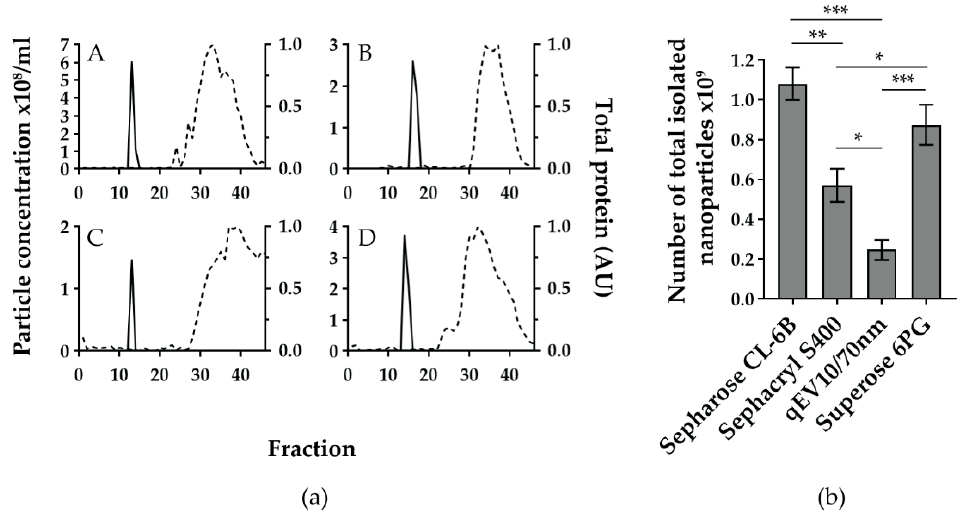
Figure 2. The four gravity-based size exclusion chromatographies (SEC) separate cerebrospinal fluid (CSF) to nanoparticle and free protein-enriched fractions but differ in yield of total nanoparticle number. ( a ) Sepharose CL-6B ( A ), Sephacryl S-400 ( B ), qEV10/70nm ( C ), and Superose 6PG ( D ) were used to separate the same pool of intracranial CSF samples from severe traumatic brain injury patients. For each SEC method, 46 fractions of approximately 1.5 mL were collected and analysed for nanoparticle concentration (solid line), measured by tunable resistive pulse sensing (TRPS) and total protein content (dashed line) expressed as arbitrary units of quantified image of Ponceau-stained membrane after slot blot. Quantification was performed using Image J software. Shown are representative graphs out of three experiments for each SEC method. ( b ) Total number of isolated nanoparticles per analysed SEC method was calculated by adding up nanoparticle numbers from TRPS positive fractions. Mean values with standard deviations from three experiments are shown for each SEC method. * p < 0.01, ** p < 0.001, *** p < 0.0001 based on the one-way ANOVA with Tukey’s post-hoc test.